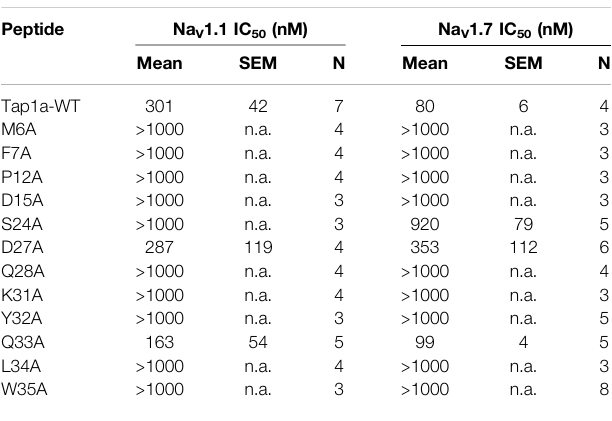
TABLE 1 | Pharmacological activity of Tap1a alanine mutants for hNa V 1.1 and hNa V 1.7 determined by automated electrophysiology in QPatch 16X. The values for the Tap1a wild type (WT) were obtained from our previous study (Cardoso et al., 2021). Tap1a alanine mutants were tested at up to 1 μ M concentration.